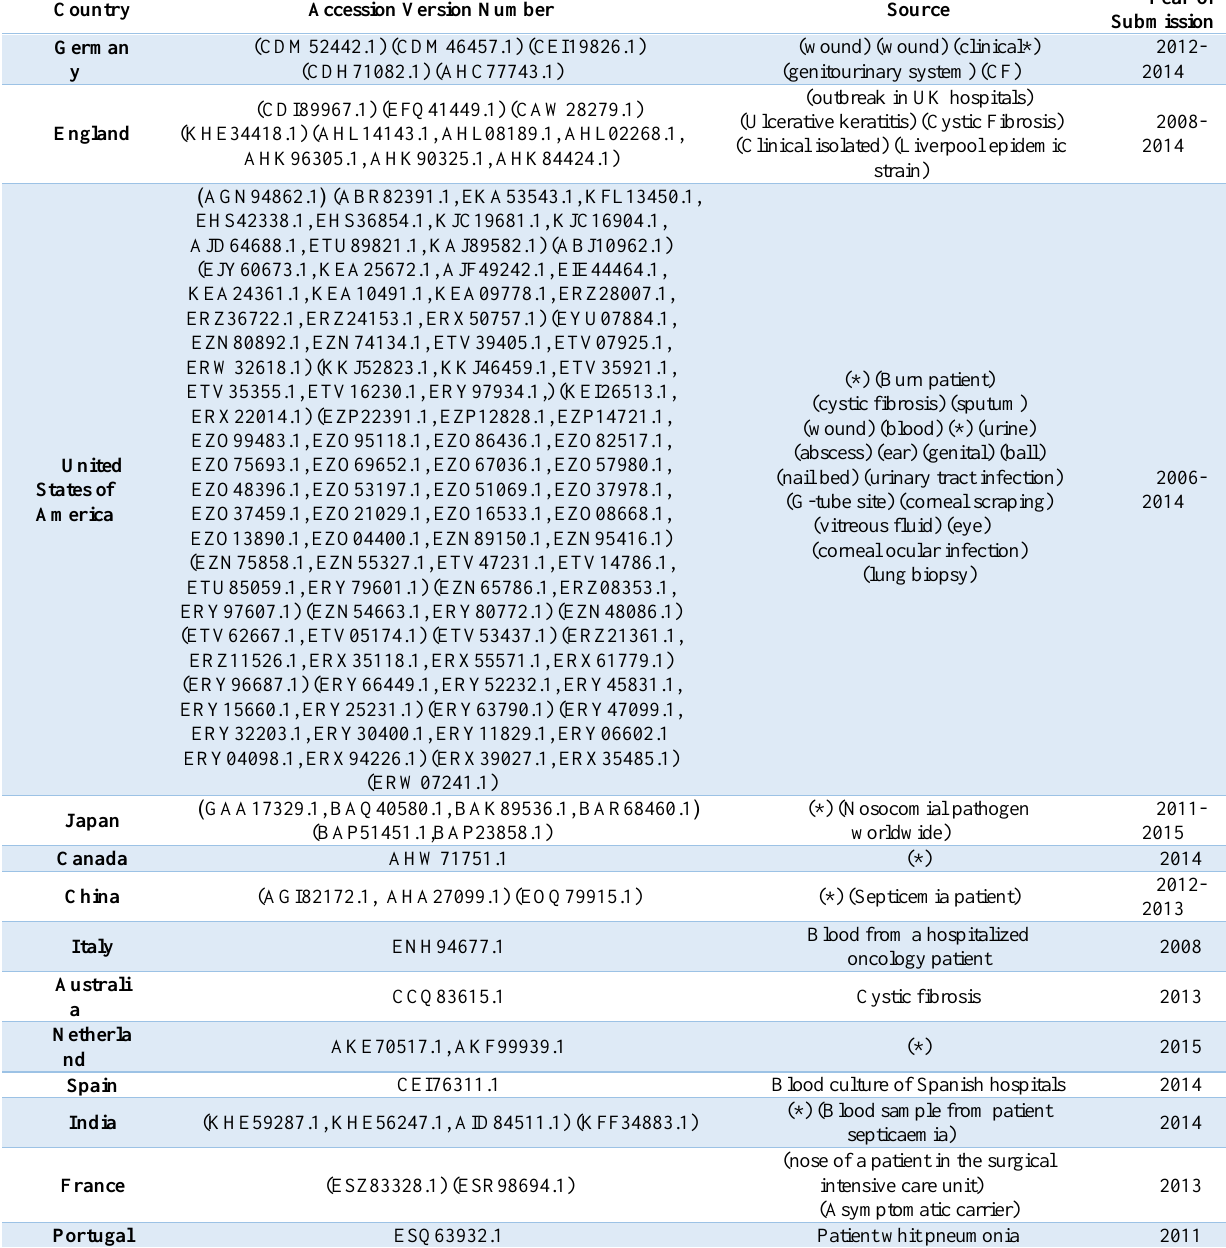
Table2. Information About the Distribution of Clinical Isolates of Pseudomonas